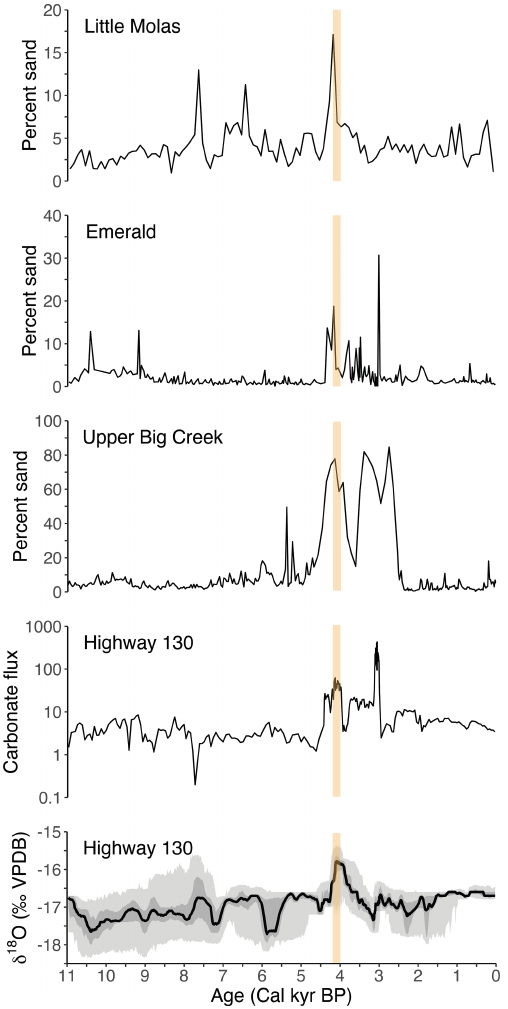
Figure 7. Spikes in the sand content of Little Molas, Emerald, and Upper Big Creek lakes, located in high-elevation watersheds in Col- orado (Fig. 1), align with the positive δ 18 O carb excursion at High- way 130 Lake and indicate low water from approximately 4.2–4ka (orange shaded areas) resulting from low effective moisture (Shu- man et al., 2009, 2014,